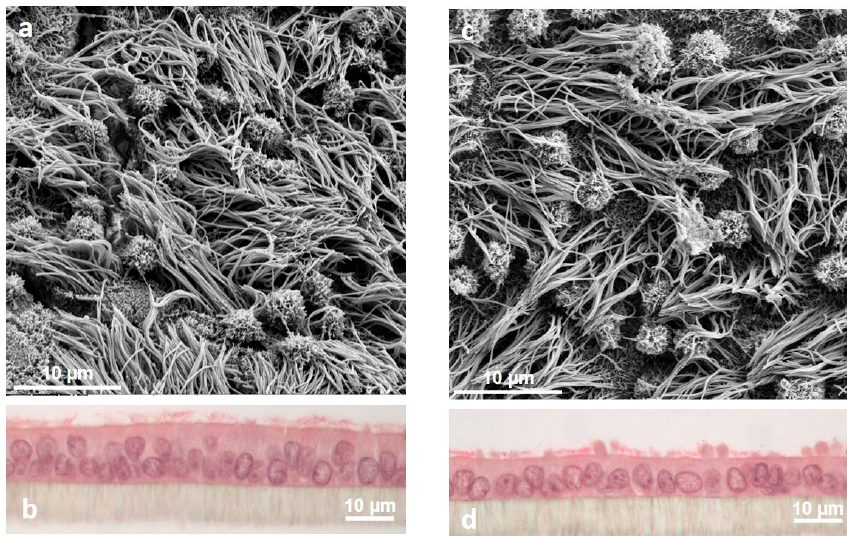
Figure 4. Morphological changes of porcine oviduct epithelial cells under the influence of sex steroid hormones during simulated estrous cycle in vitro. Scanning electron microscopy showed the apical ultrastructure in simulated follicular ( a ) and luteal phase ( c ), respectively; magnification 5000 × . ( b ) and ( d ): Hematoxylin eosin staining; magnification 400 ×.